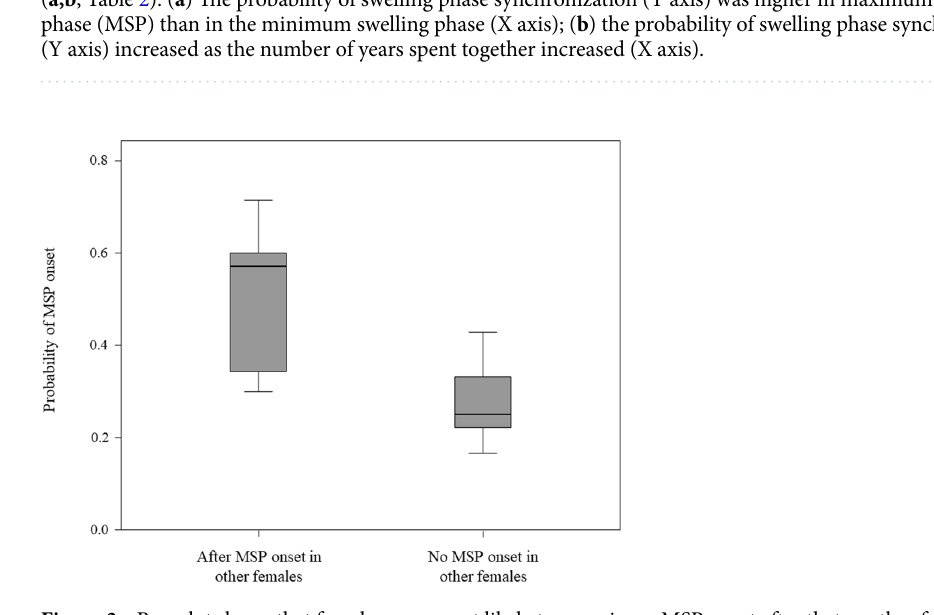
Figure 3. Box plot shows that females were most likely to experience MSP onset after that another female had experienced MSP onset in a three-day time window. Solid horizontal lines: medians; box length: interquartile range; thin horizontal lines: value